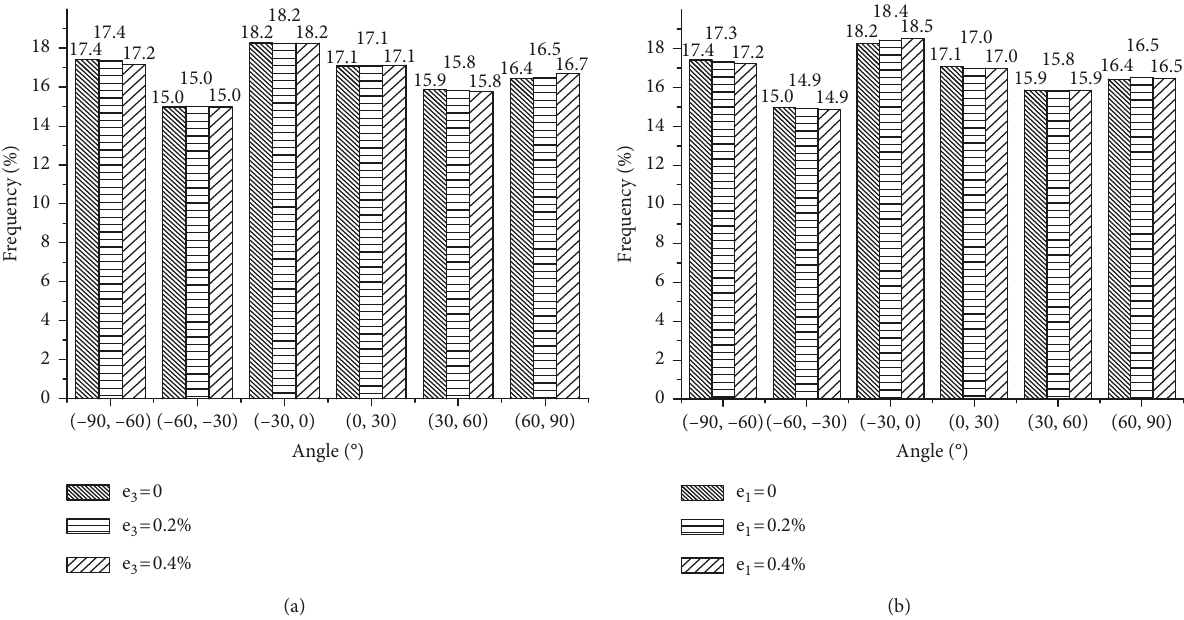
Figure 10: Distribution of major axis orientation of particles: (a) F1 sample long axis orientation change; (b) F2 sample long axis orientation